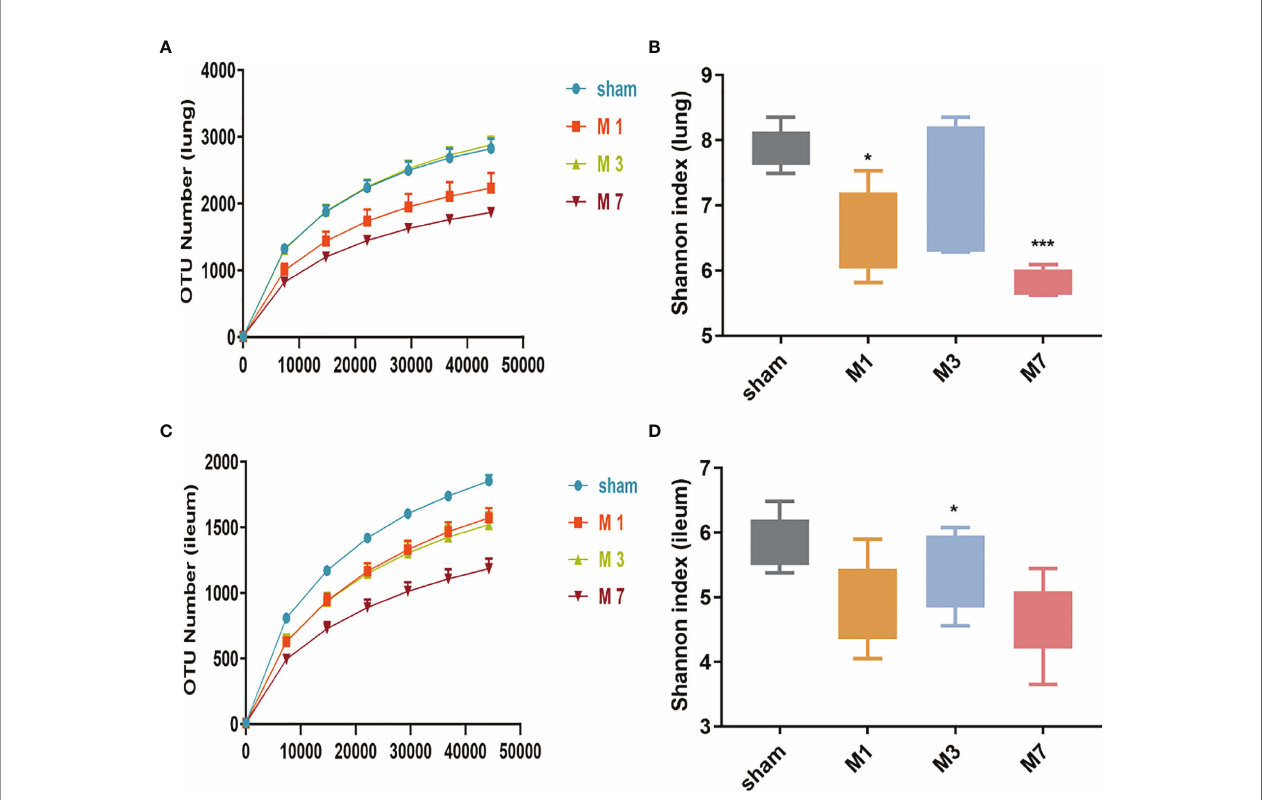
FIGURE 5 | Species richness and diversity of the gut microbiome inthe ICH model at different time points. (A,B) The rarefaction curveand Shannon diversity index in the lung show signi fi cantlyreduced species diversity on days1 and 7 after ICH. (C,D) The rarefaction curveand Shannon diversity index inthe ileum show signi fi cantly reduced species diversity induced on day 7 d after ICH. Data are expressedas the mean ± standard deviation.*P<0.05 and ***P<0.001. vs. sham